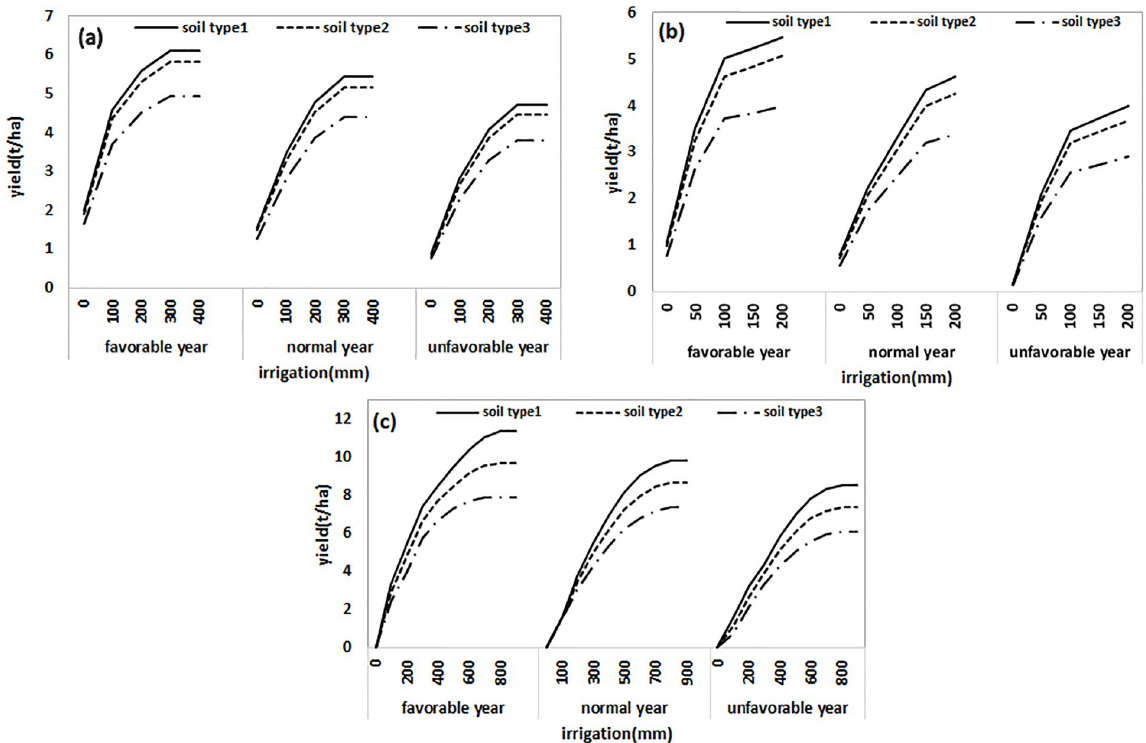
Fig 3. Crop yield function in different soils (soil type1: EC < 4, soil type2: 4 < EC < 8, soil type3: EC > 8 ds m -1 ) under different climatic conditions (wet, normal, dry year): (a) wheat, (b) barley, and (c) maize.